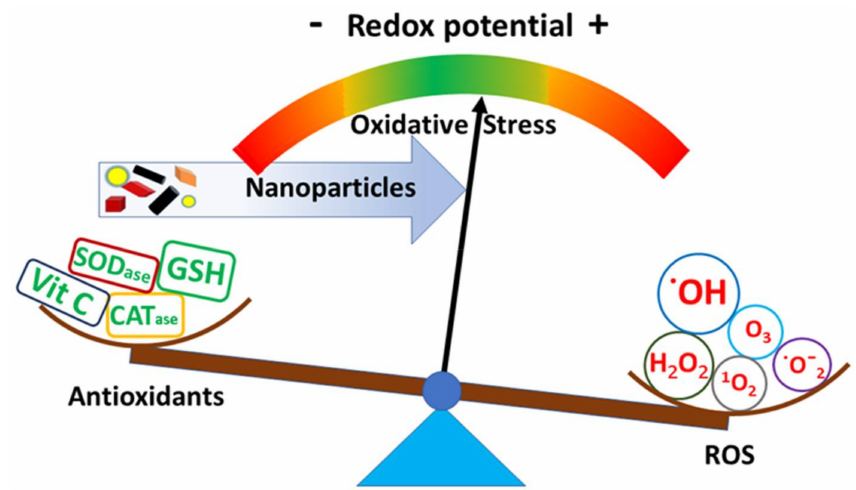
Figure 1. A significant shift in a biological system redox potential generates oxidative